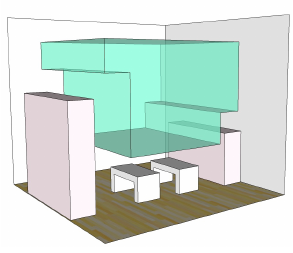
Figure 1. Free space for UAV in indoor environments.